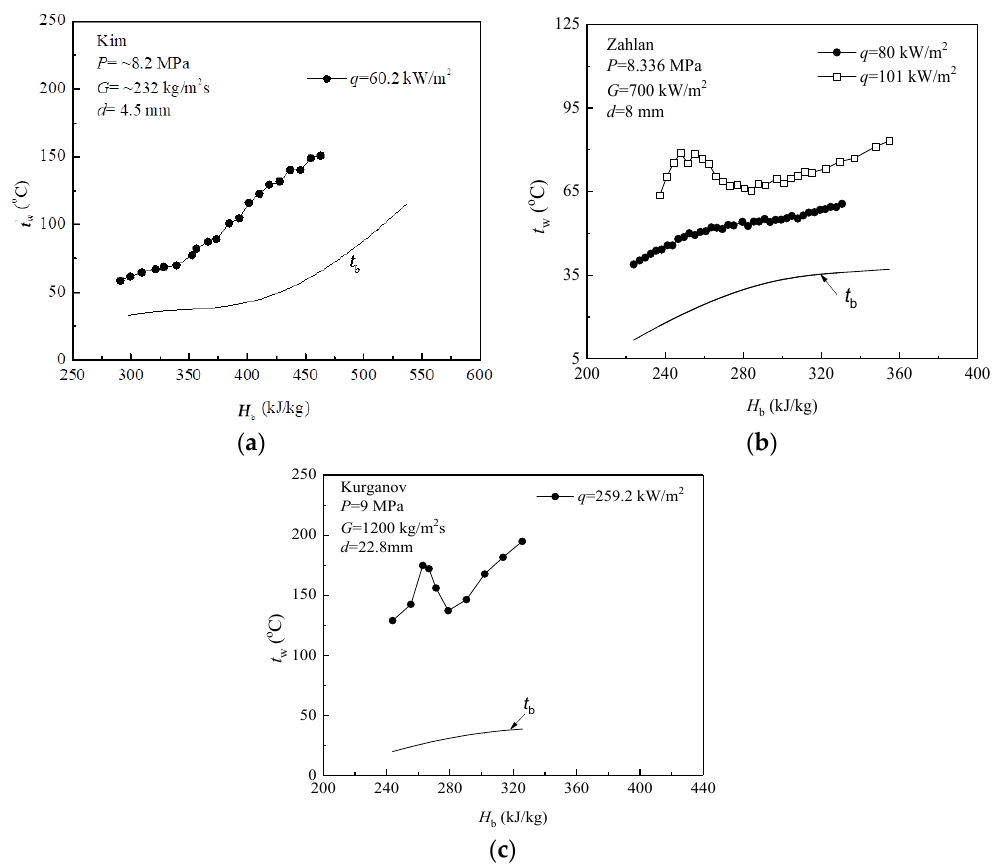
Figure 2. Profiles of the inner-wall temperatures for different mass fluxes. ( a ) Mass flux ( G ) = 232 kg/m 2 s (data from Kim [26]); ( b ) G = 700 kg/m 2 s (data from Zahlan [27]); ( c ) G = 1200 kg/m 2 s (data from Kurganov [28]).